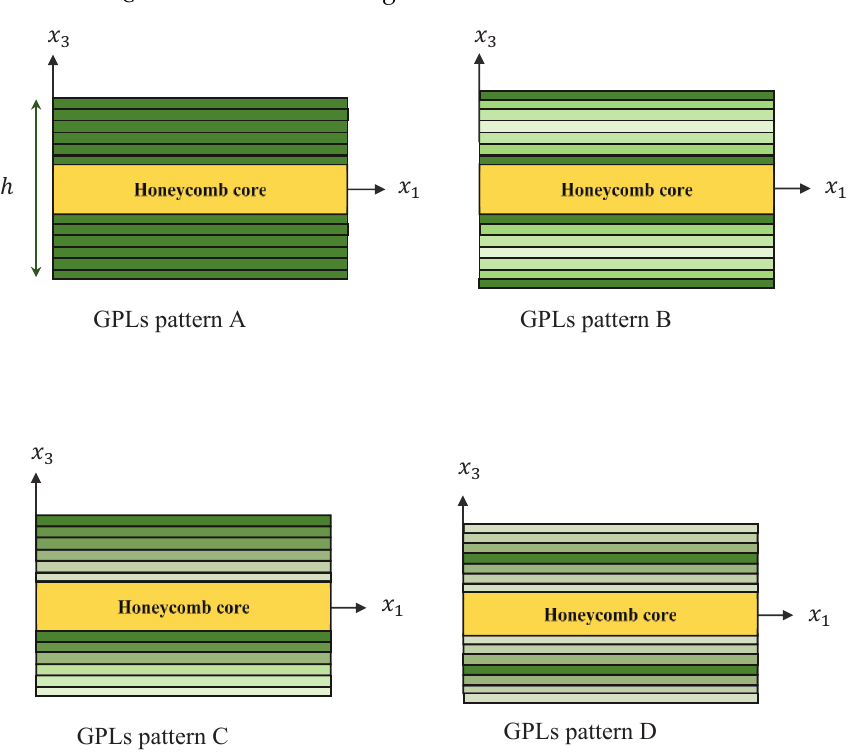
Figure 2. Four patterns of GPLs distribution of naocomposite FG GPLs-reinforced piezoelectromag- netic